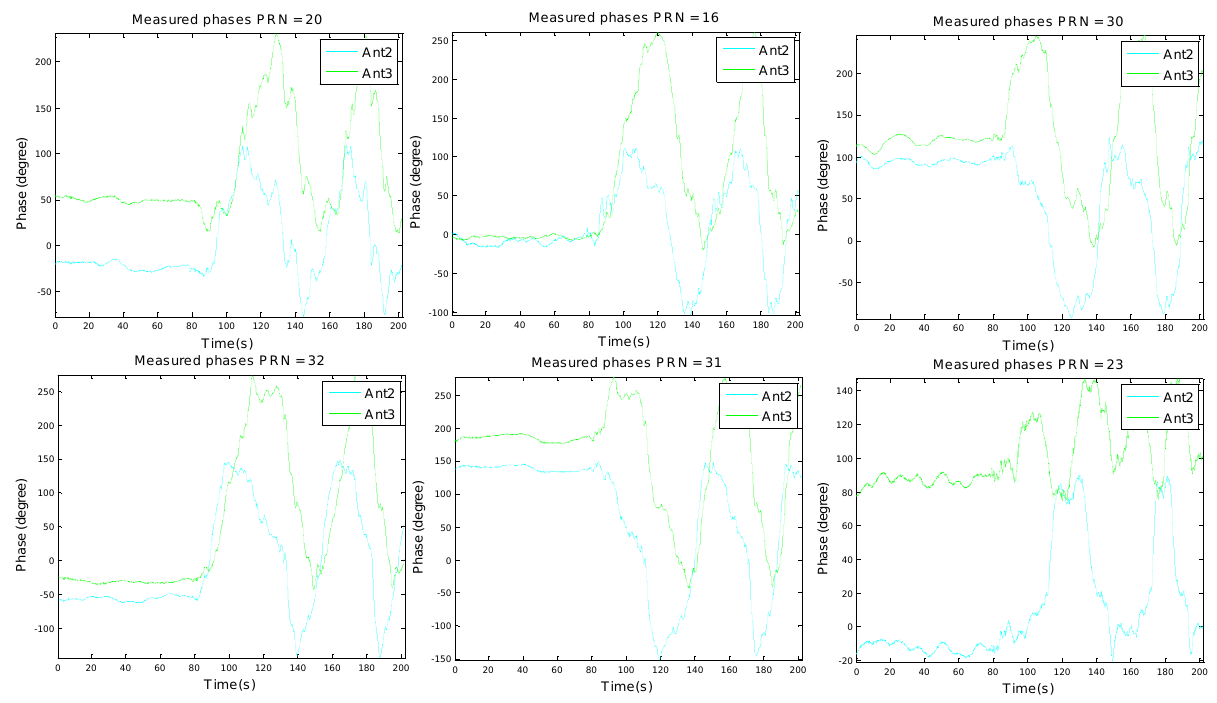
Figure 8. Measured phases for Antenna 2 and Antenna 3 for PRNs 20, 16, 30, 32, 31 and